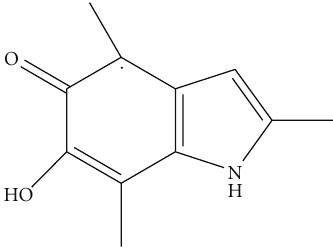
Figure 1: Semiquinone radical trapped in melanin, responsible of the paramagnetic properties of the